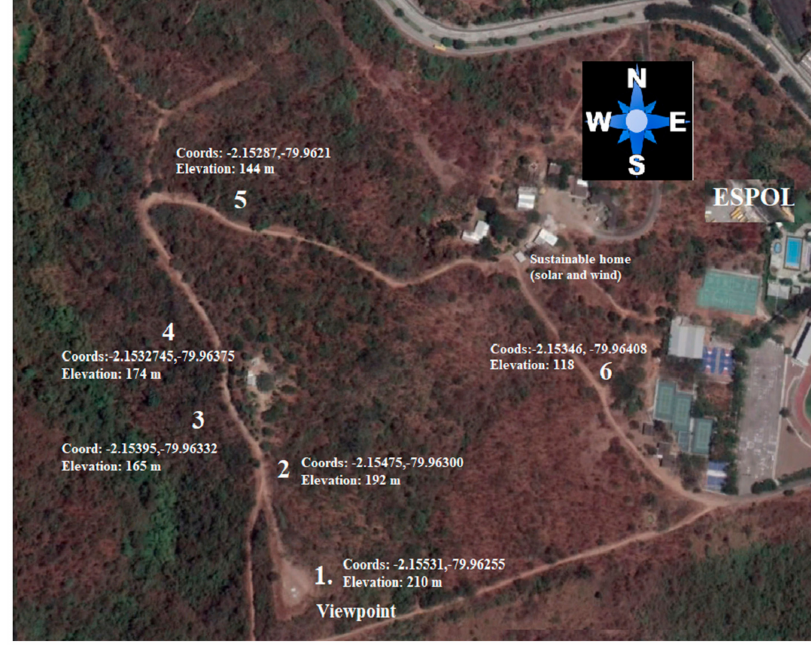
Figure 1. Location map of the autonomous stations.